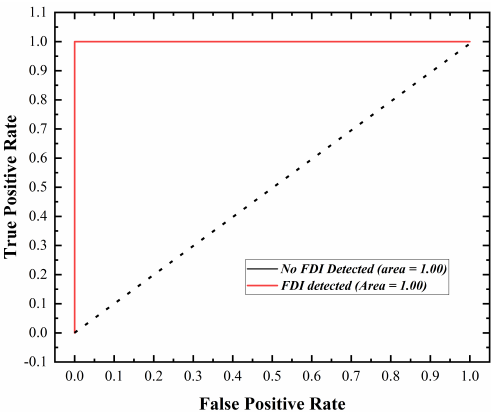
Figure 9. The ROC-AUC curve for proposed algorithm trained on minutely dataset.